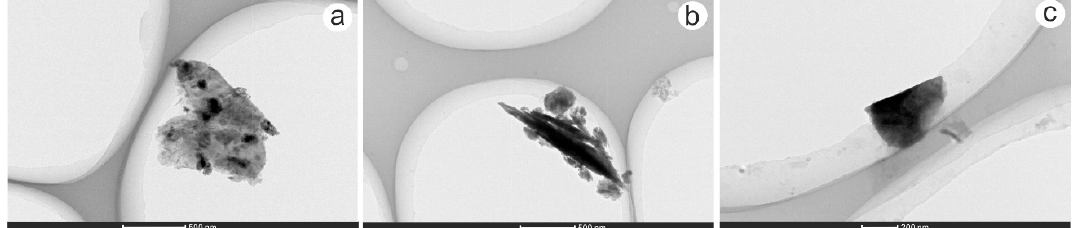
Figure 11. TEM images of Fe-bearing nanoparticles in the studied fault gouge samples. ( a ) Fe-bearing nanoparticles adsorbed to clay minerals; ( b ) Fe-bearing nanoparticles adsorbed to clay minerals; ( c ) a Fe-bearing nanoparticle.